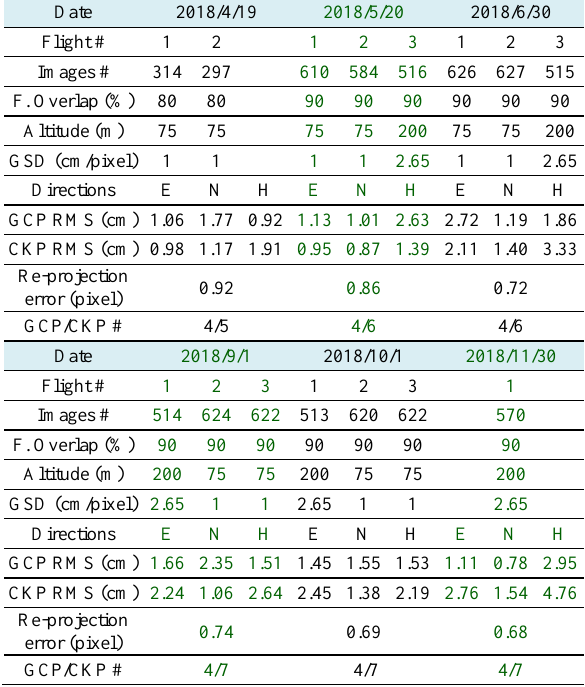
Table 2. Statistics of aerial triangulation